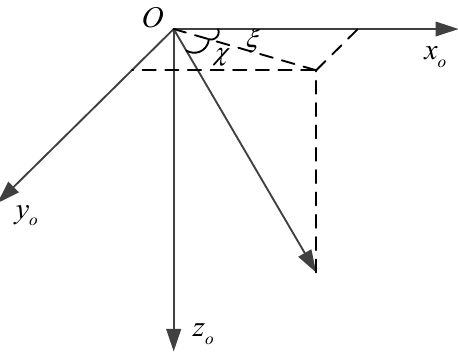
Figure 4. The azimuth angle ξ and elevation angle χ of the boresight vector.